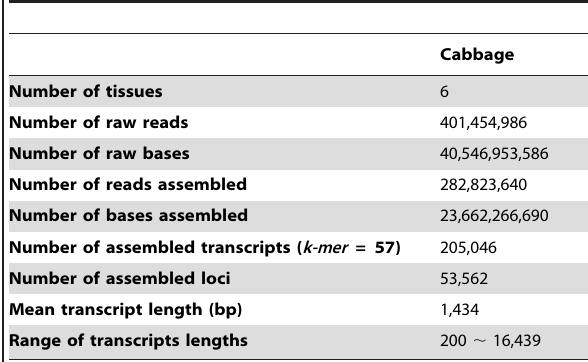
Table 1. Summary of short-read data from cabbage produced using Illumina